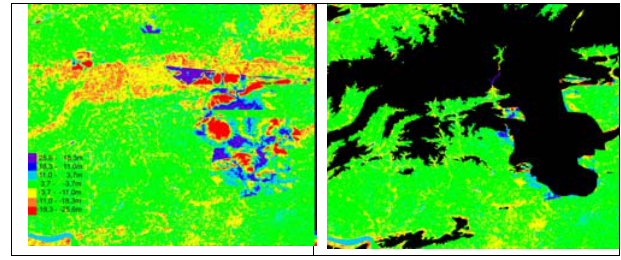
Figure 2: color coded height discrepancies SRTM DSM Pennsylvania against reference DTM, left: whole area, right: only open area without soil degradation